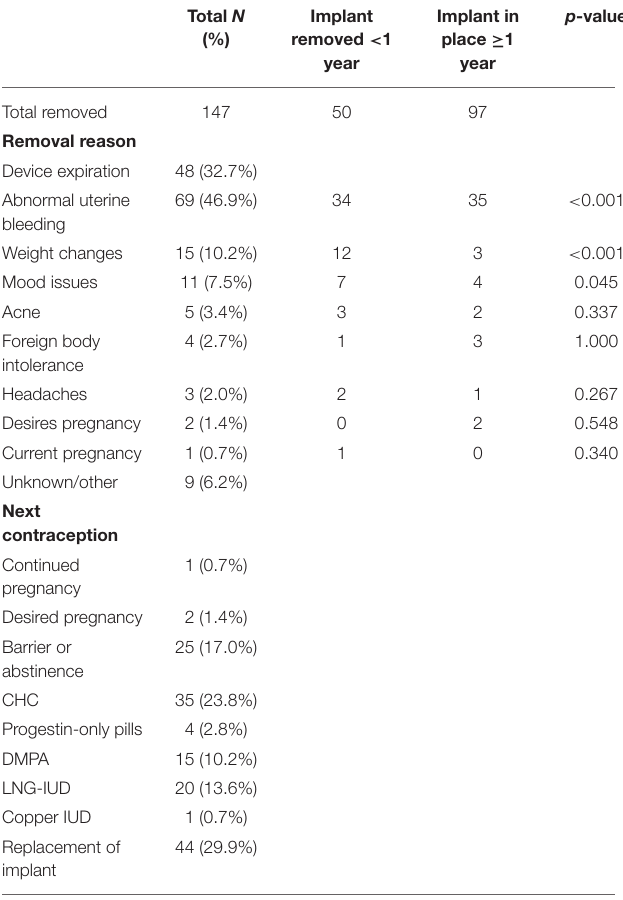
TABLE 3 | Outcomes following implant placement.